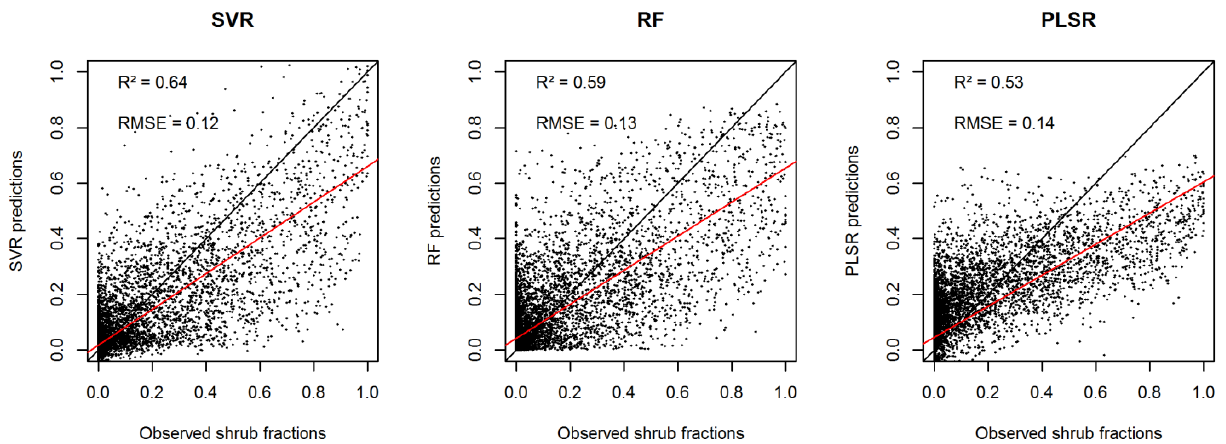
Negative outliers of SVR and PLSR are not